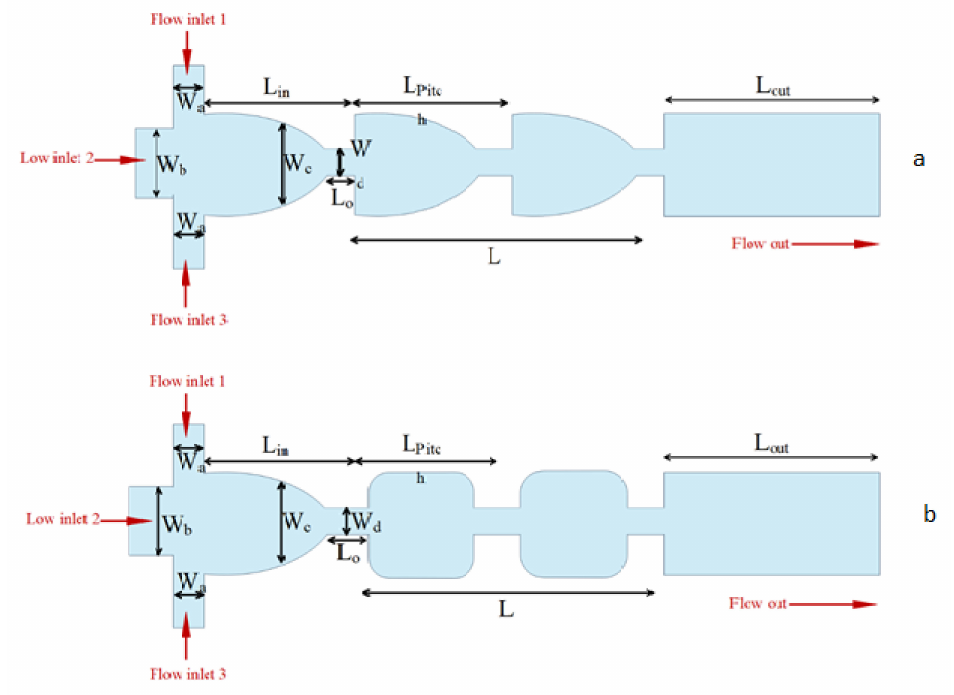
Figure 31. ( a ) Hexagonal chamber (H) and ( b ) round corner rectangular chamber design of planar micromixer (RCR) [249]. Daghighi and Li [250] presented a novel design of a micromixer based on electrokinetic as in Figure 32. The mixer consists of a cylindrical chamber that is connected to two microchannels at the inlet and outlet of the channel, with suspended, fully conductive, circular particles. By applying an external electric field, vortices are created around the conductive particle and increase the mixing percentage. The final position of the particle and the vortex strength depend strongly on the applied electric field. They found that applying an electric field at a 45-degree angle increased the mixing percentage. Moreover, by applying a stronger electric field, the mixing time is